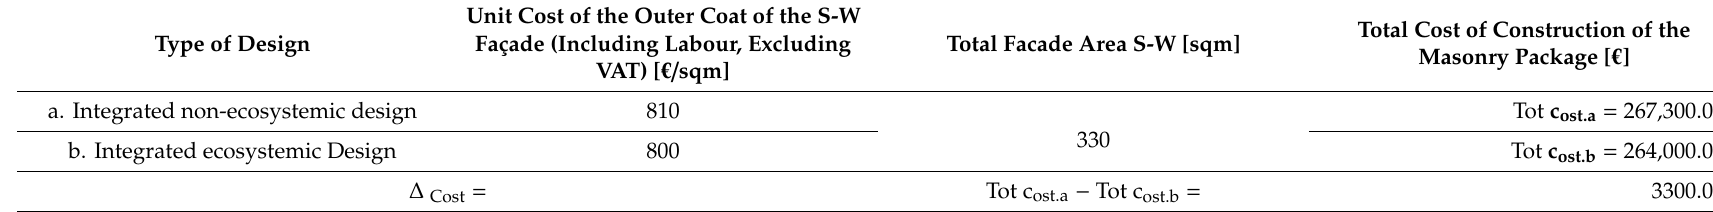
Table 8. Estimated construction costs of the outer coat of the building’s S-W facade.